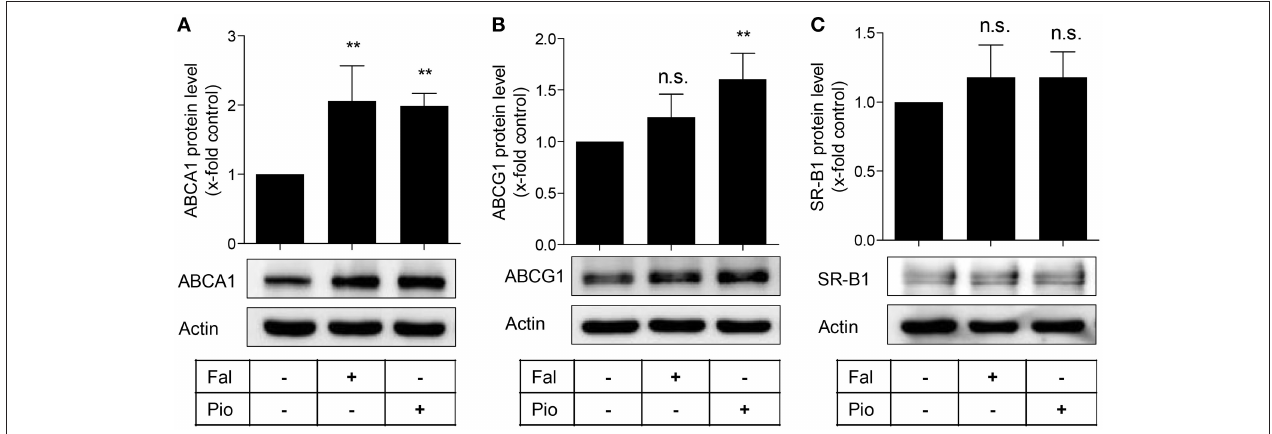
FIGURE 2 | Falcarindiol increases ABCA1 protein level. Differentiated THP-1 macrophages were treated with solvent vehicle control (DMSO), falcarindiol (Fal, 10 µ M), or the PPAR γ agonist pioglitazone (Pio, 10 µ M). After 24 h, cells were lysed and 20 µ g protein was resolved via SDS-PAGE. Immunoblotting was performed with antibodies against the indicated proteins, ABCA1 (A) , ABCG1 (B) , and SR-B1 (C) as well as actin as loading control. All experiments were performed four times and values are presented as means ± SD and vs. solvent vehicle control (DMSO): ** p < 0.01, n.s. not significant (ANOVA/Bonferroni).